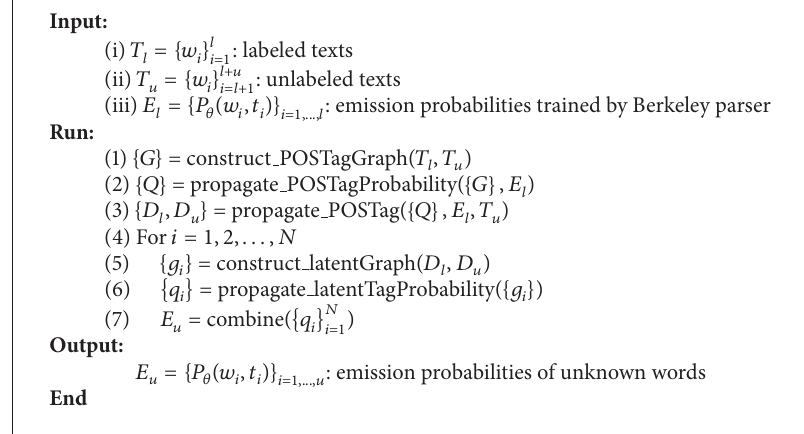
Algorithm 1: Words label propagation algorithm.